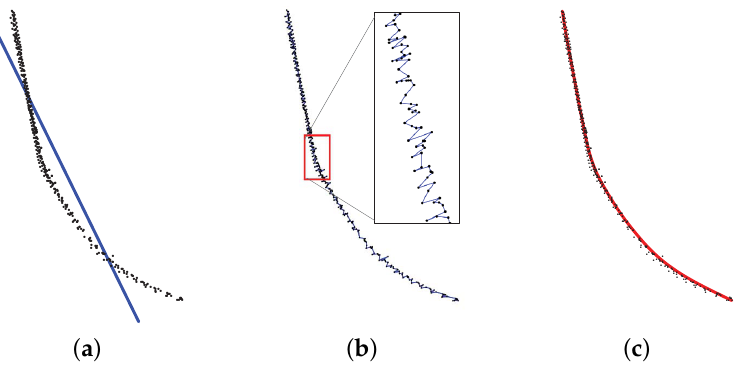
Figure 2. Procedure of generating centerline from points by the robust Locally-Weighted Scatterplot Smooth (Lowess) algorithm. ( a ) Points and the abscissa ( x -axis) calculated by PCA; ( b ) points sorted in ascending order according to their x values; ( c ) line generated by the robust Lowess